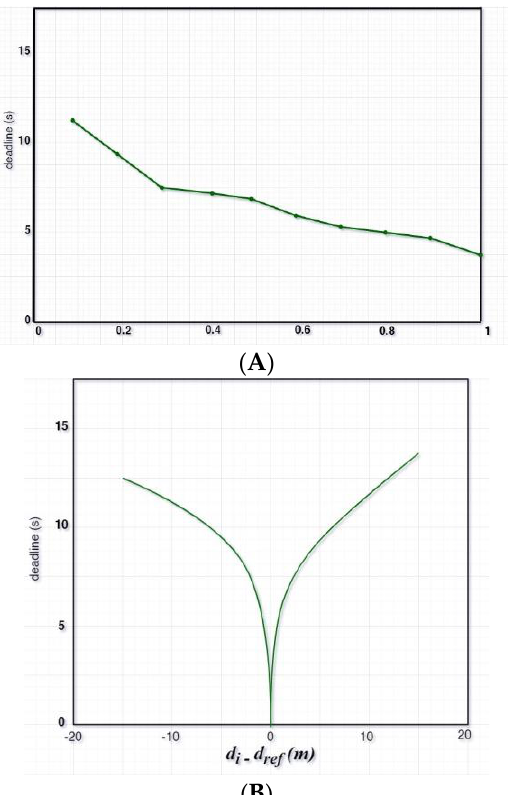
Figure 11. ( A ) Checkpoint distance threshold γ ( B ) the deadline duration when γ = 0.3m.